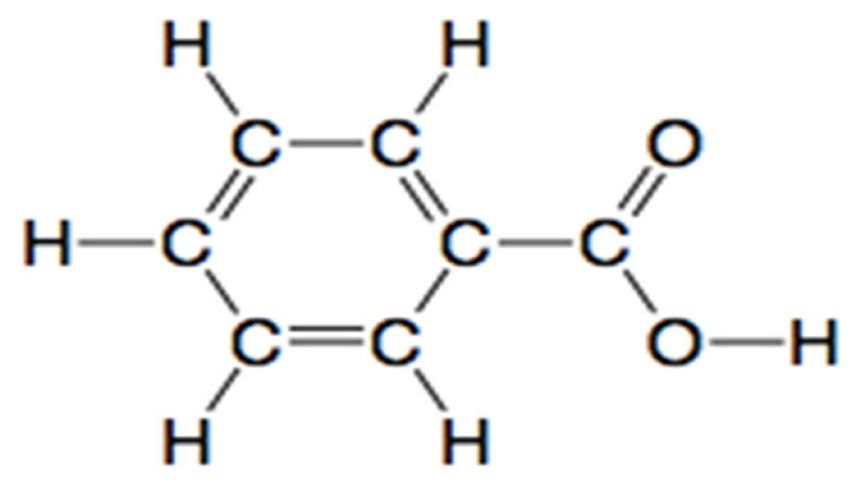
Figure 19. Chemical structure of an isolated metabolite (benzoic acid). 3.6. Proposed Biodegradation Pathway for the Biodegradation of Methyl Red by P. aeruginosa The results of FTIR, GC-MS, and NMR indicated that the molecule of the methyl red dye was broken down by P. aeruginosa and new products or metabolites were formed. A number of bacterial species such as Enterococcus faecalis YZ 6, Pseudomonas sp., and Bacillus sp. have azoreductase enzymes [72–75]. The azo linkage (–N=N– bond) of methyl red was broken by the enzyme azoreductase enzyme of P. aeruginosa and converted to two substituted benzene derivatives, dimethylaminobenzene and 1-amino benzoic acid. Fur- thermore, 1-amino benzoic acid was converted to benzoic acid through deamination process by deaminase enzymatic action. The deaminase enzyme of the bacterial system influences the conversion of N,N-dimethylaminobenzene to N,N-dimethyl benzene by deamination reaction. After that, the reductive demethylation of N,N-dimethyl benzene possibly could form an aminobenzene ring. The aminobenzene molecule undergoes deamination by the bacterial deaminase enzyme, leading to the formation of benzene. Methyltetrahydrofo- late and methyl donors S-adenosyl-methionine are already in present bacteria enzymes and have been reported to be involved in benzene ring methylation [76]. As a result, methylation occurs and benzene is converted to o-xylene. Figure 20 shows a proposed biodegradation pathway for the biodegradation of methyl red by P. aeruginosa